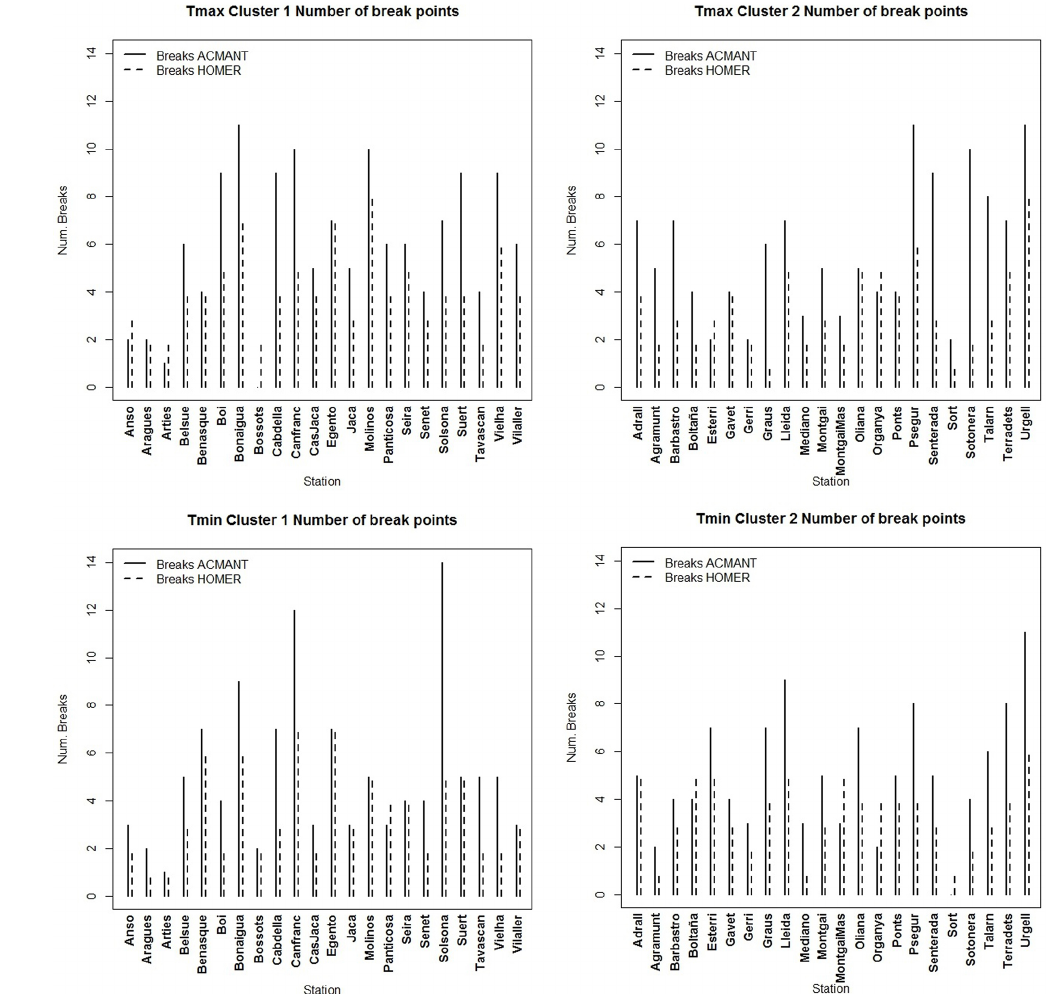
Figure 4. Number of break points detected by ACMANT (continuous line) and HOMER (dashed line) for each station for T max (top panels) and T min (bottom panels) in cluster 1 (left panels) and cluster 2 (right